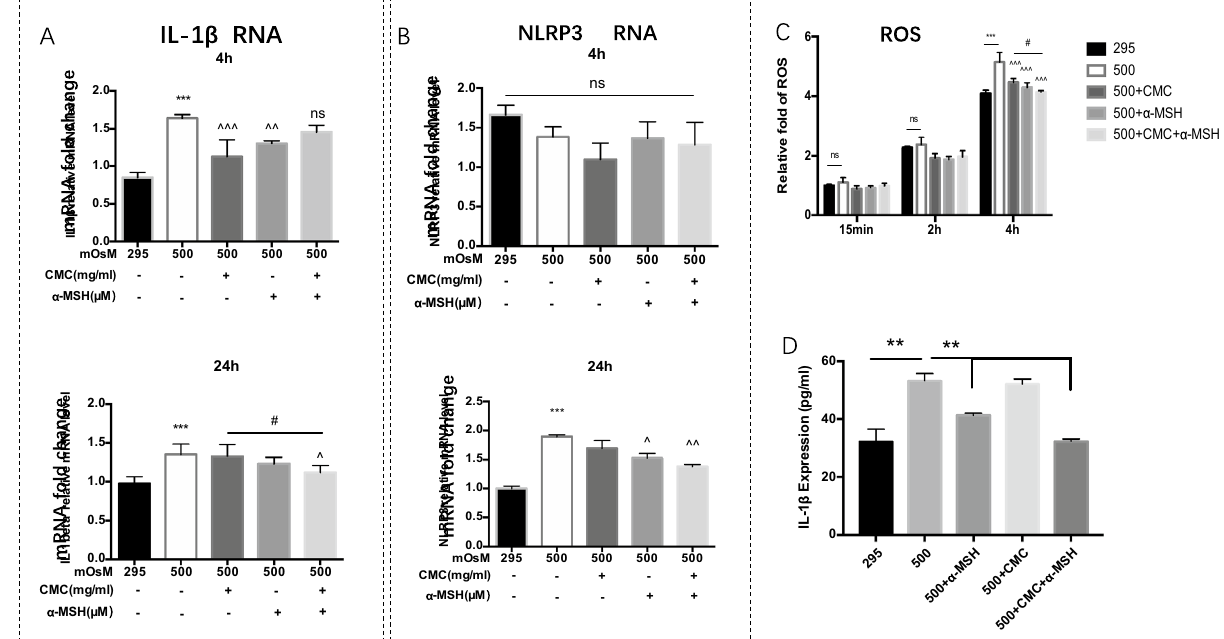
Figure 6. Combined CMC + α-MSH treatment reduced mRNA levels of NLRP3 and IL-1β in HCECs exposed to hyperosmotic environmental stress. mRNA levels of NLRP3 and IL-1β among groups after 4 h ( A ) and 24 h ( B ) of treatment are shown. Relative expression levels were analysed using the comparative threshold cycle (2 −∆∆Ct ) method and normalised to GAPDH gene expression. ROS levels were compared among groups treated with CMC, α-MSH, and CMC + α-MSH in a hyperosmotic environment, or left untreated ( C ). IL-1β expression in cell supernatant ( D ). Data are shown as mean ± SEM. Three independent experiments were performed, n = 6 per group. *, comparison of dry eye group and normal group; ^, comparison of α-MSH treatment group or combined CMC + α-MSH treatment group and hypertonic group; #, comparison of CMC treatment group and combined CMC + α-MSH treatment group; ns, not significant. *, # p < 0.05; ** p < 0.01; *** p <